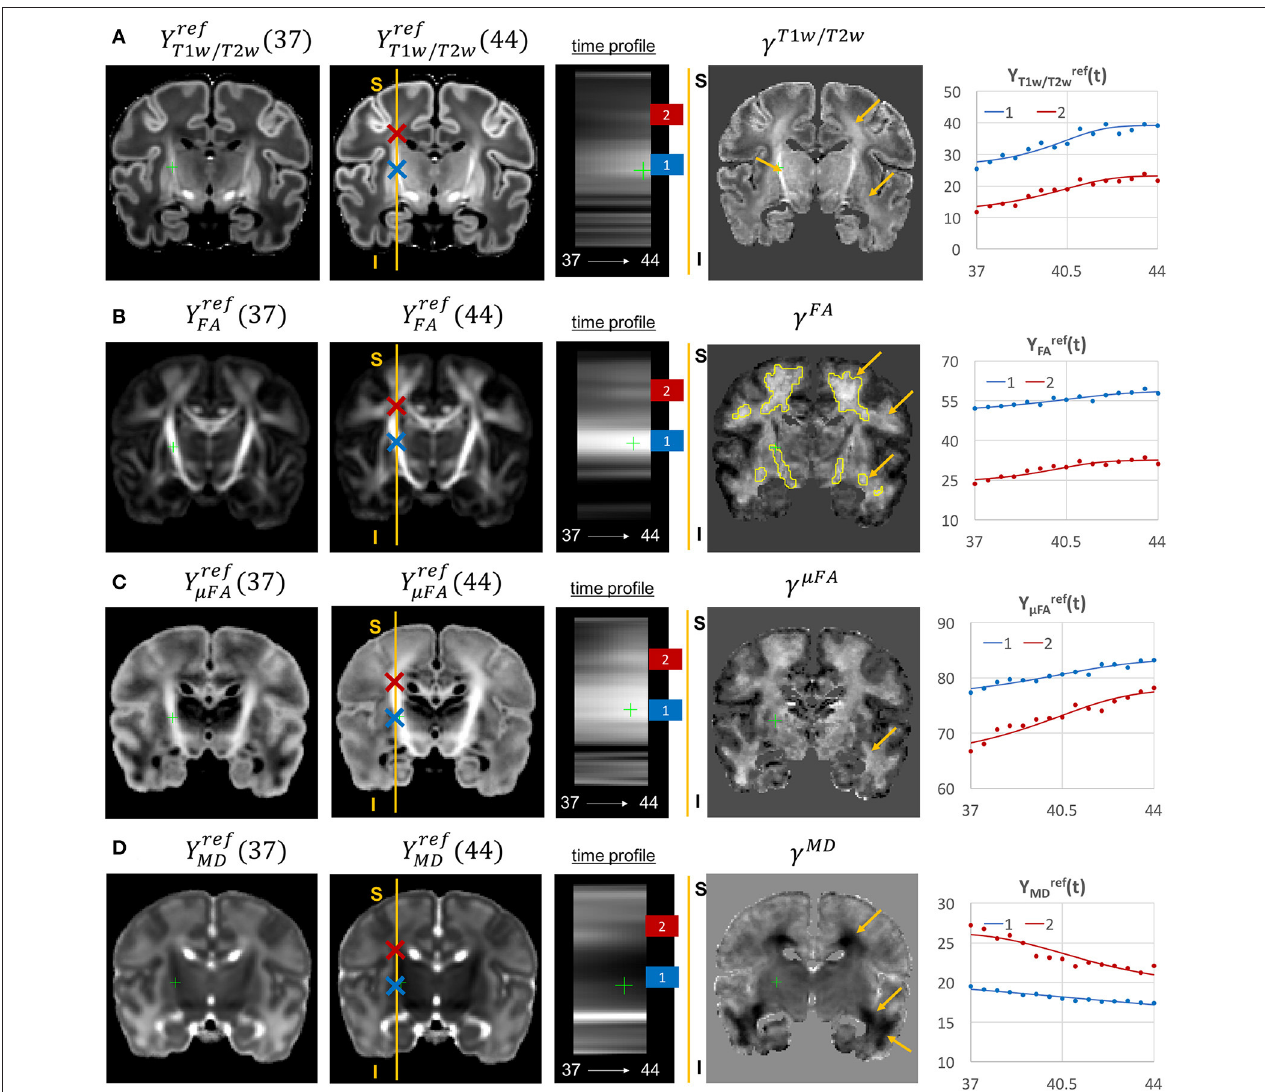
FIGURE 11 | Examples of the signal changes in time (in the reference space) in T1w/T2w (A) , FA (B) , µ FA (C) , and MD (D) channels. First column: 37 week template. Second column: 44 week template. Third column: signal change in time. Fourth column: γ c maps. Fifth column: Signal change in time in age-specific templates Y (2) c , t and fitted Gompertz function Y ref c ( t ) computed over 3 × 3 × 3 voxel regions in two locations: PLIC (blue) and superior corona radiata (red). The regions highlighted with yellow contours have > 0.2 weeks growth peak offset in τ c .